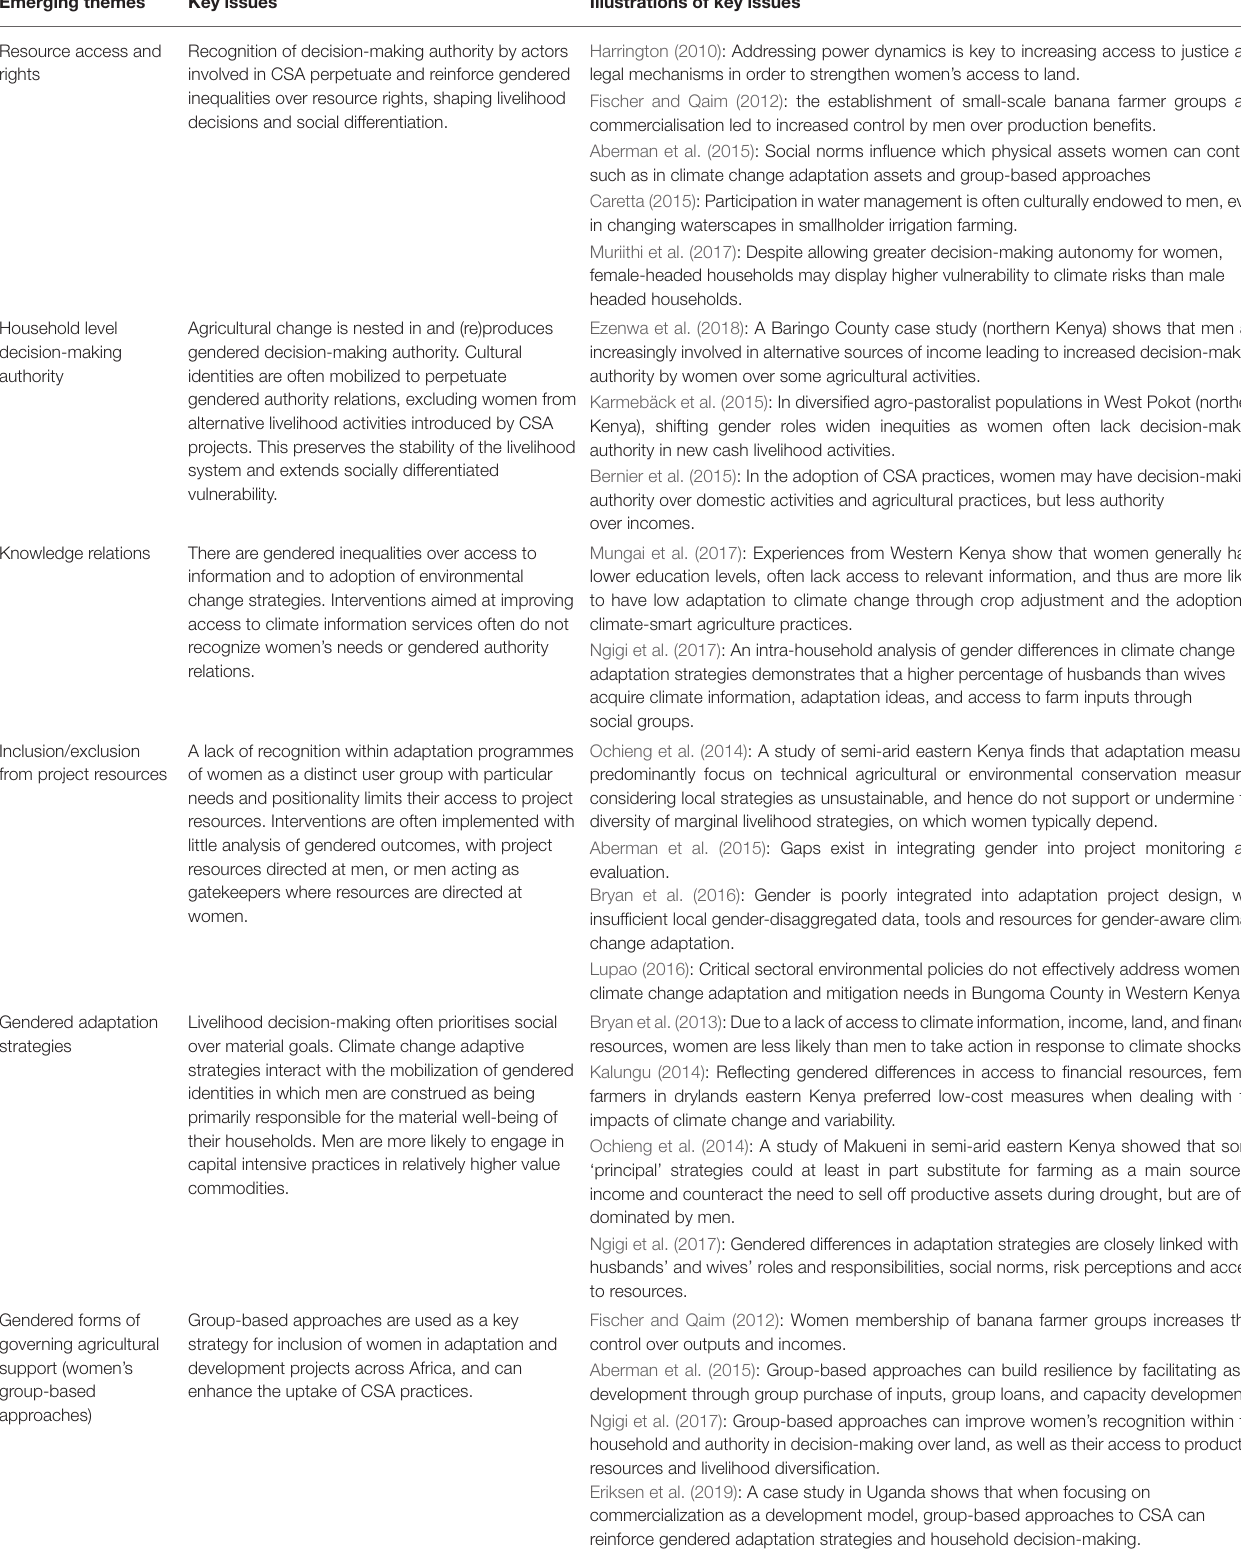
TABLE 2 | Summary of emerging themes describing how CSA reshapes gender relations and social